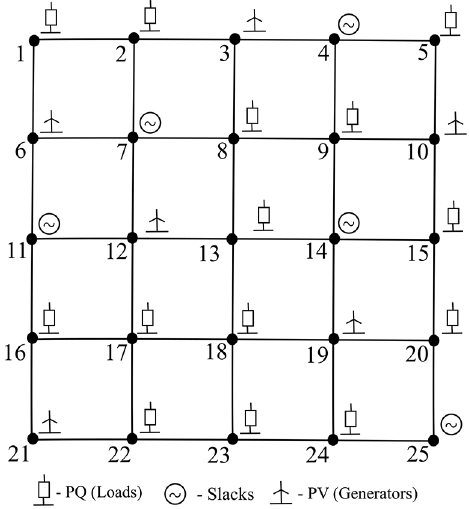
Fig. 10. – 25-node example network.